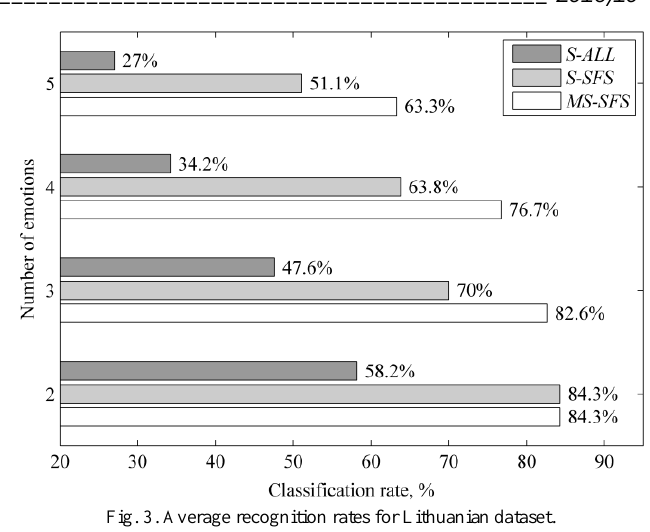
Fig. 3. Average recognition rates for Lithuanian